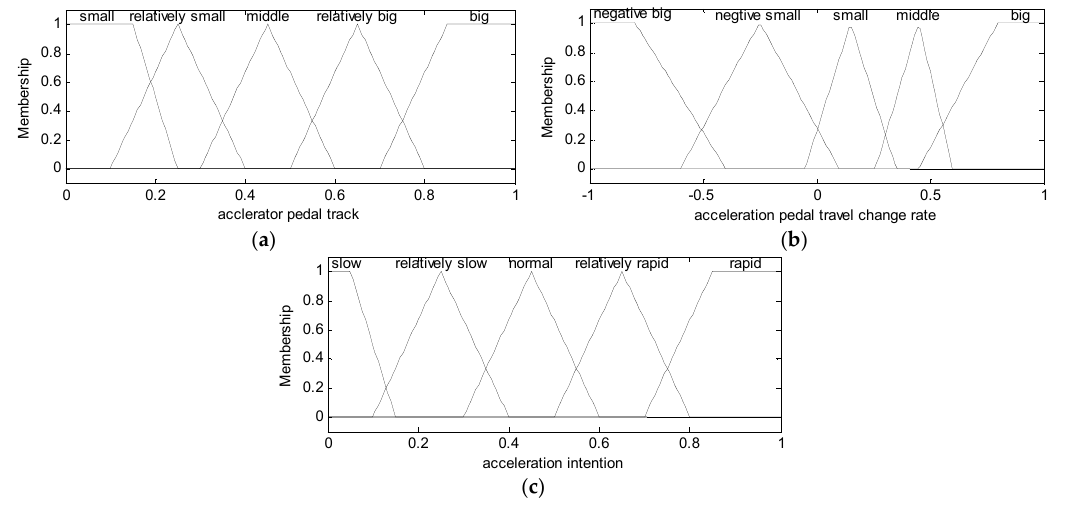
Figure 4. ( a ) Membership functions of acceleration pedal travel; ( b ) membership functions of rate of change of acceleration pedal travel; and ( c ) membership functions of acceleration intention. Table 1. The fuzzy rules for identification of the acceleration intention.